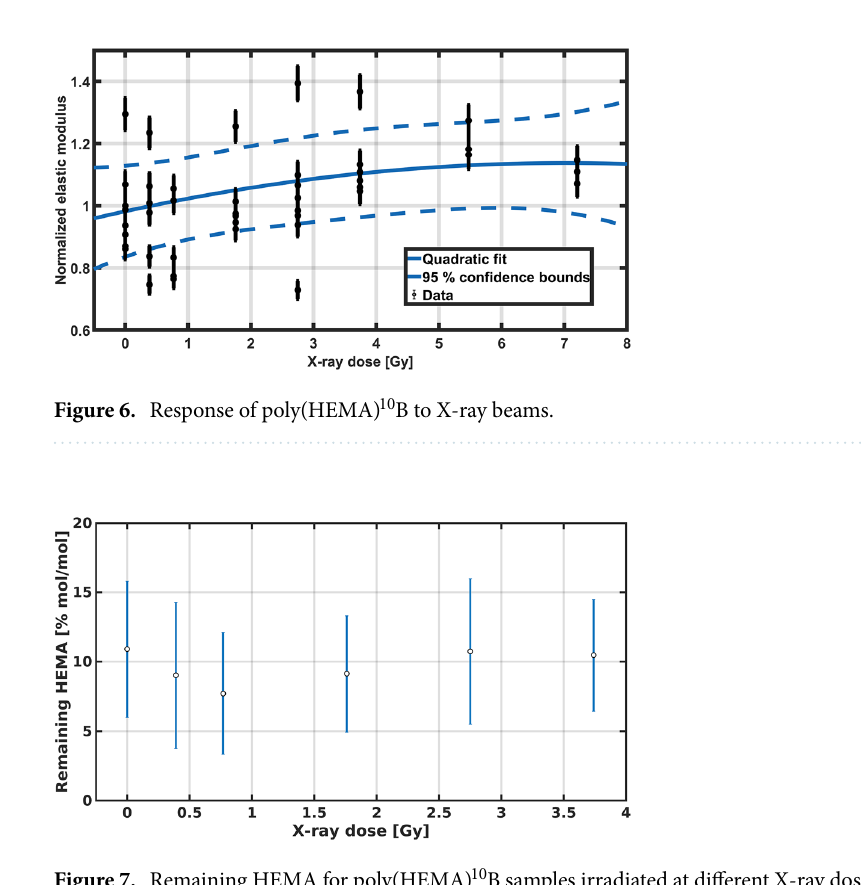
Figure 7. Remaining HEMA for poly(HEMA)